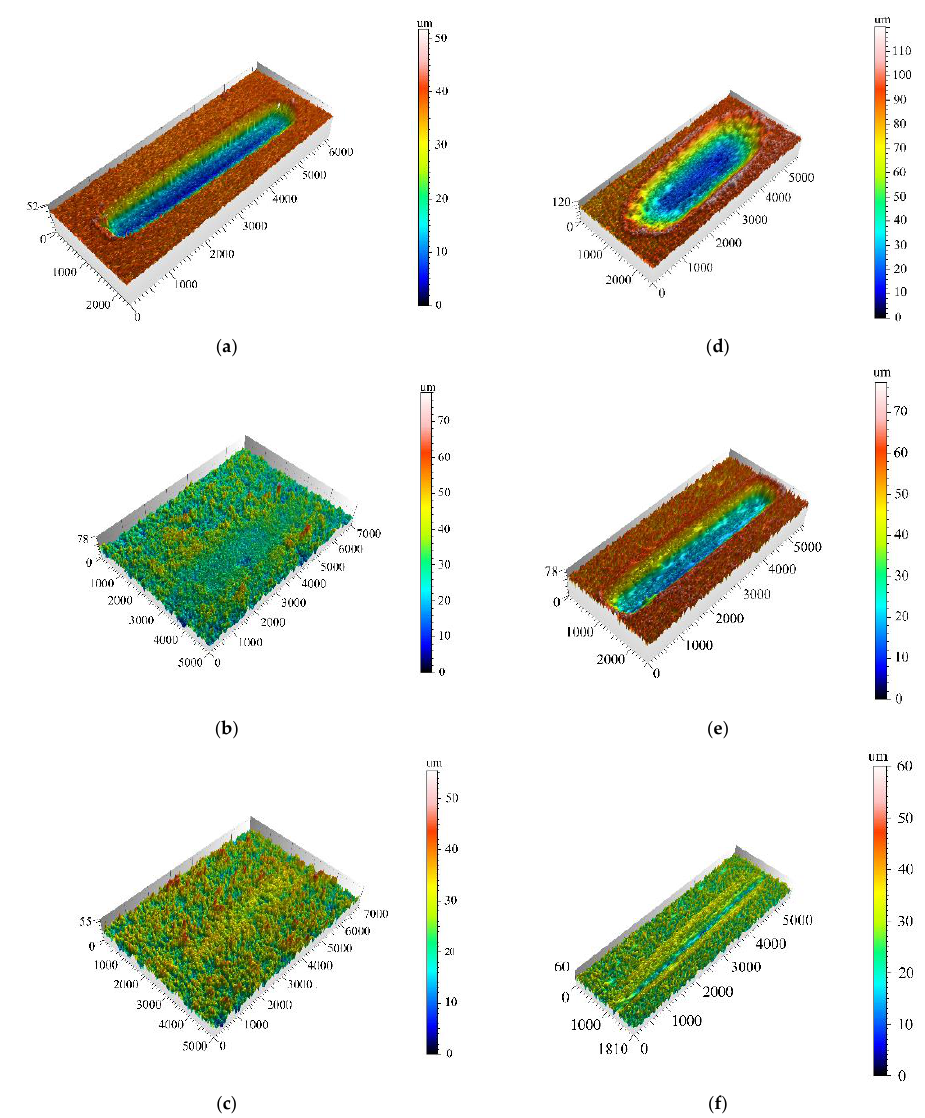
Figure 10. Three-dimensional surface wear morphology of specimens under different loading conditions. ( a ) a load of 20 N, and a time of 10 min: Sample A; ( b ) a load of 20 N, and a time of 10 min: Sample B; ( c ) a load of 20 N, and a time of 10 min: Sample C; ( d ) a load of 100 N and a time of 30 min: Sample A; ( e ) a load of 100 N and a time of 30 min: Sample B; ( f ) a load of 100 N and a time of 30 min: Sample C.